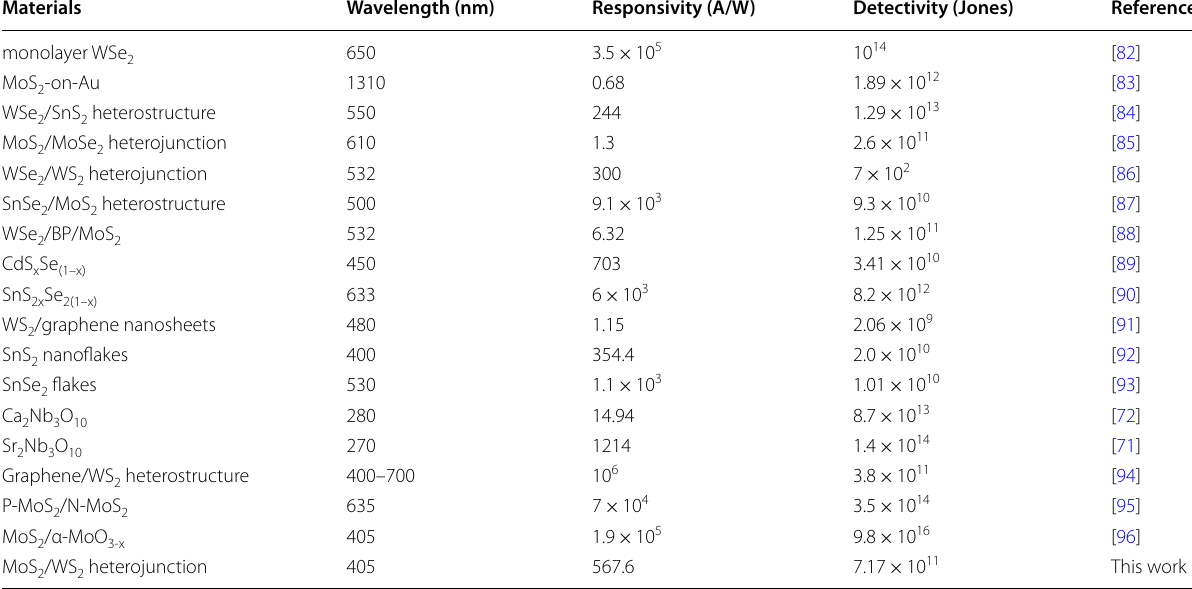
Table 1 Some photoresponse performance of selected representative photodetectors based on 2D materials